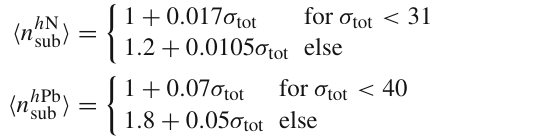
ent incoming hadrons (p, π + , K + , φ 0 , (cid:3) 0 , (cid:13) 0 , (cid:14) − ) at five different energies (10, 100, 1000, 10,000, 100,000 GeV).